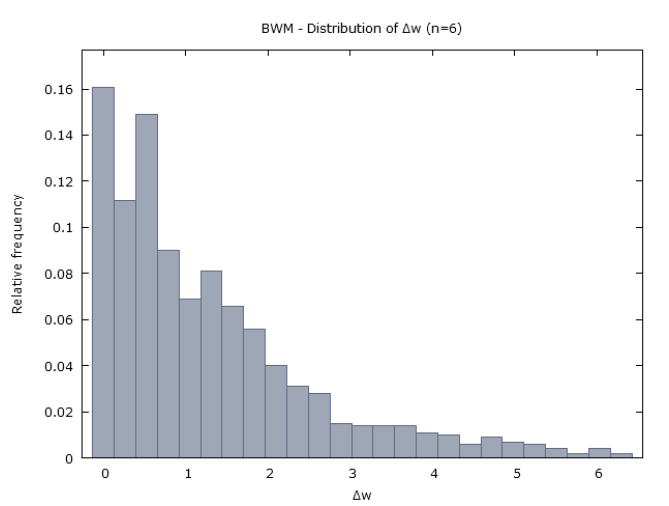
Figure 6. Sensitivity distribution: all methods, n = 8.